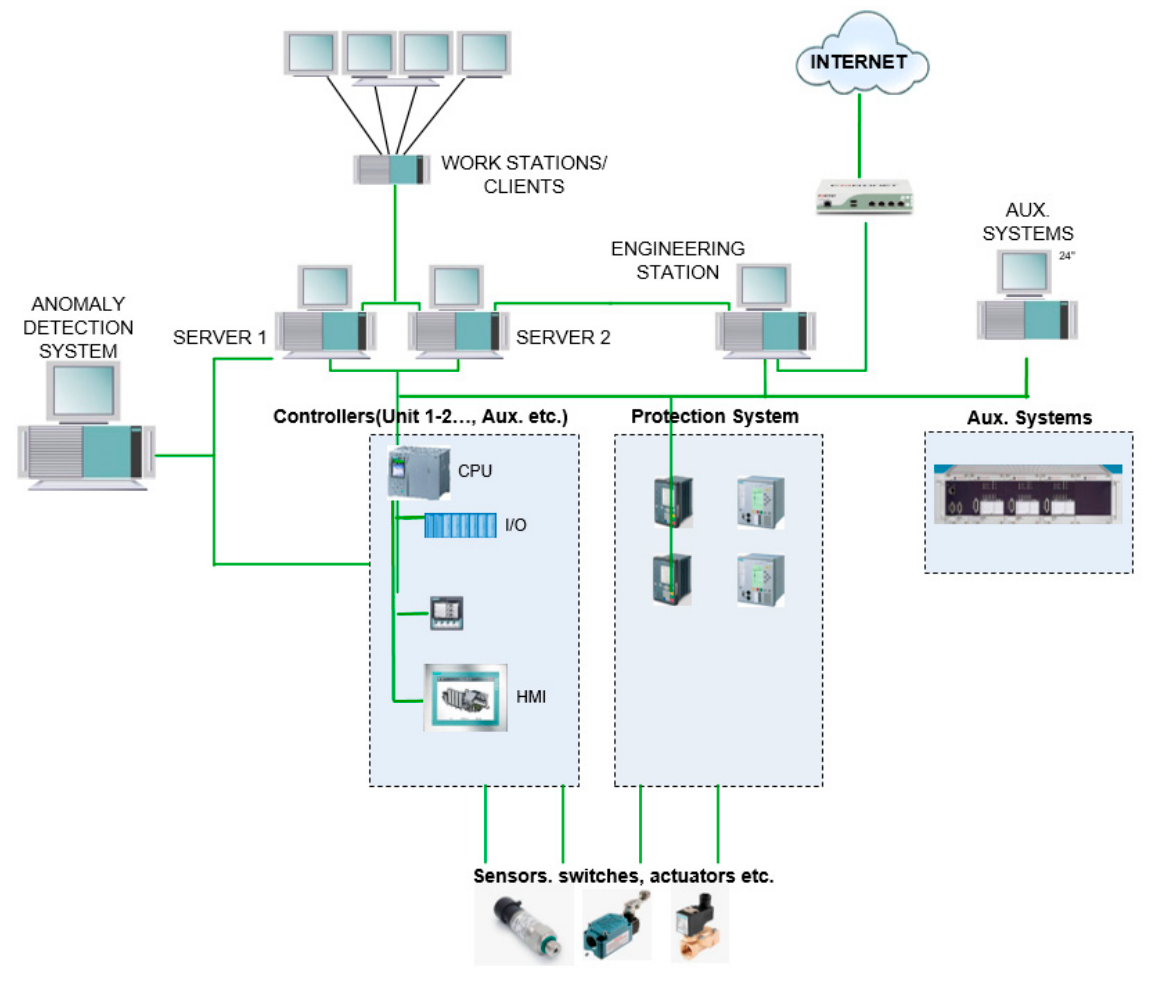
Figure 3. SCADA architecture example.